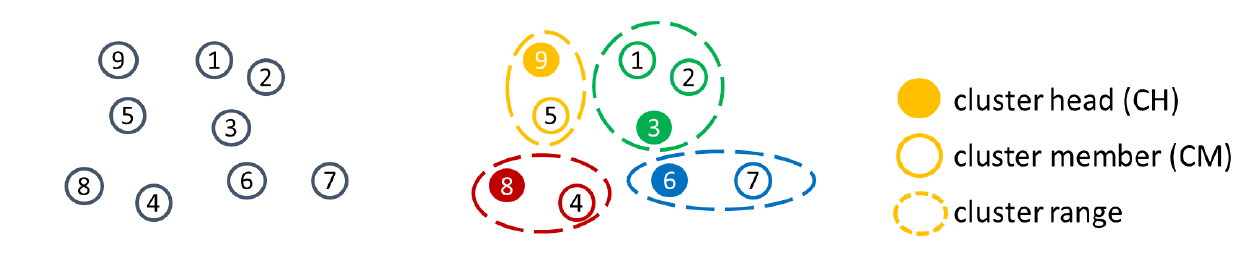
Figure 2. An example of MD